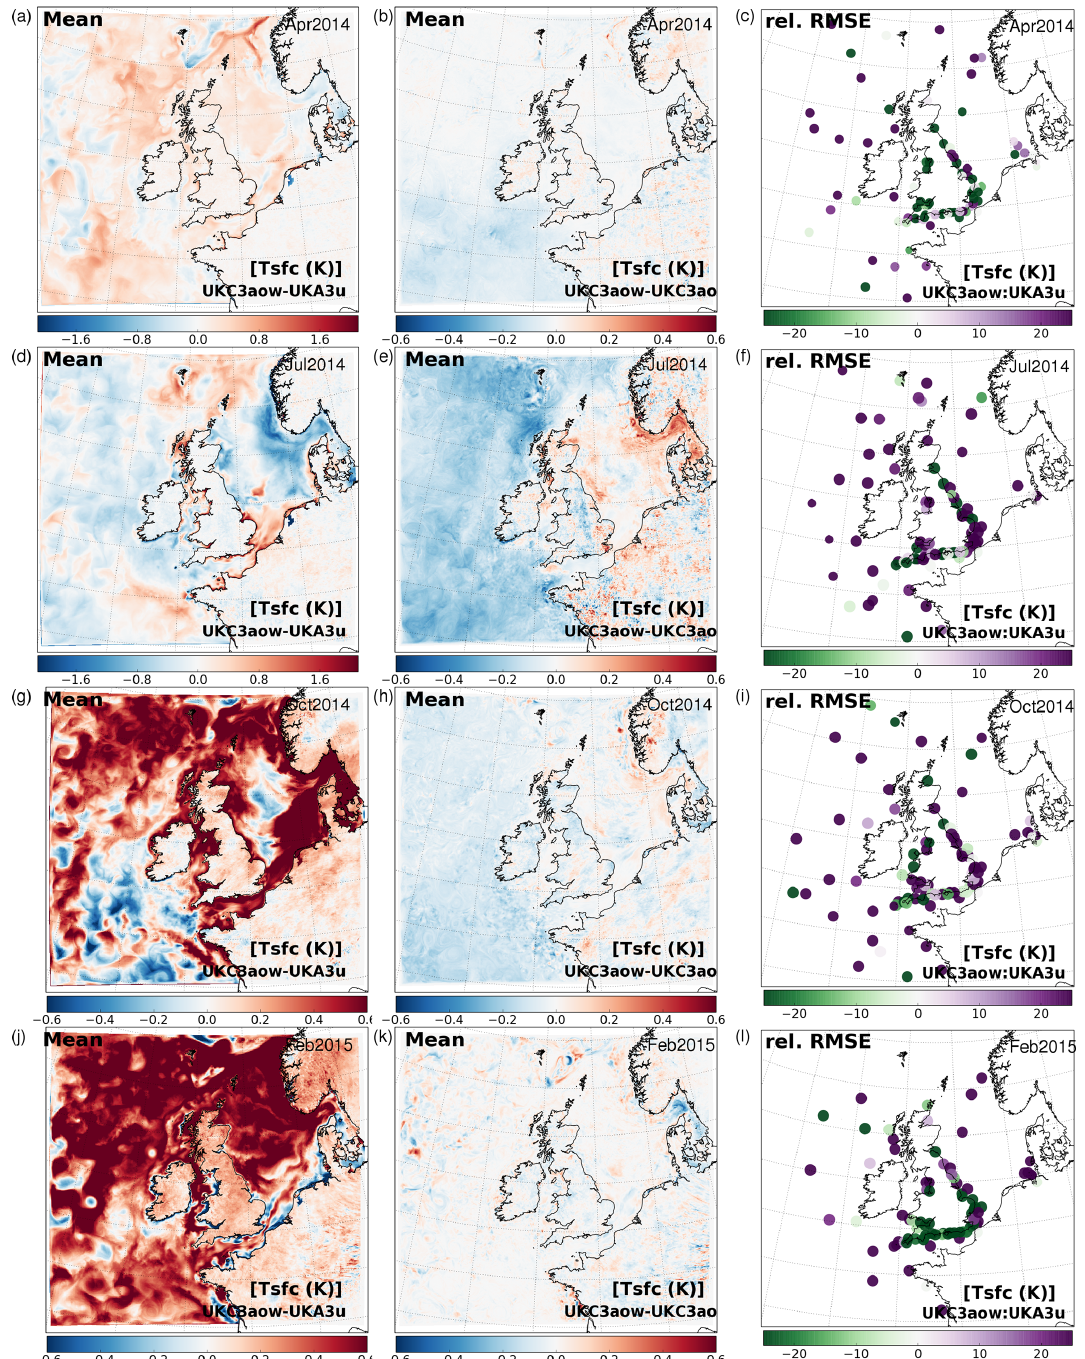
Figure 9. Sensitivity of atmosphere model surface temperature to coupling. (a, d, g, j) Monthly mean difference between fully coupled and daily-updated OSTIA (UKC3aow–UKA3u) during April, July, October 2014 and February 2015 runs, respectively. (b, e, h, k) Monthly mean difference between fully coupled and partially coupled (UKC3aow–UKC3ao) runs during each experiment. (c, f, i, l) Percentage difference in surface temperature RMSE statistic for UKC3aow relative to